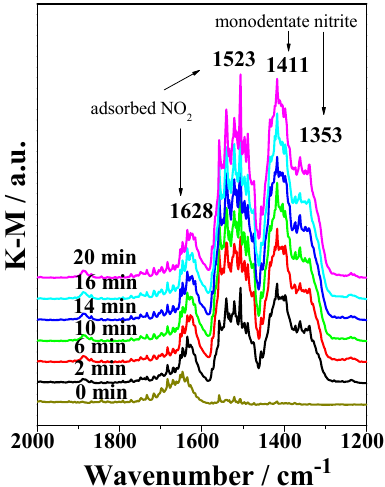
Figure 11. DRIFTS of Ru/Al 2 O 3 ‐ NaBH 4 pretreated by 0.5% N 2 O for 1 h at 300 °C, with exposure to